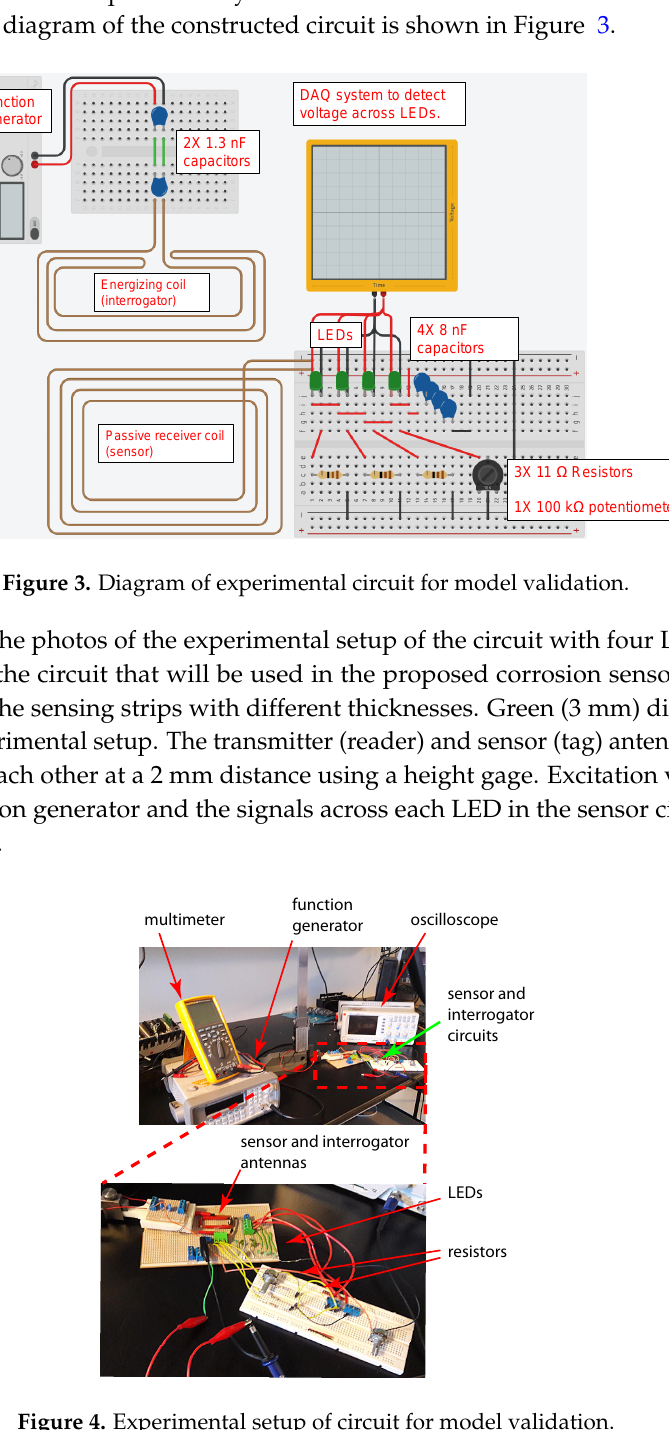
Figure 4. Experimental setup of circuit for model